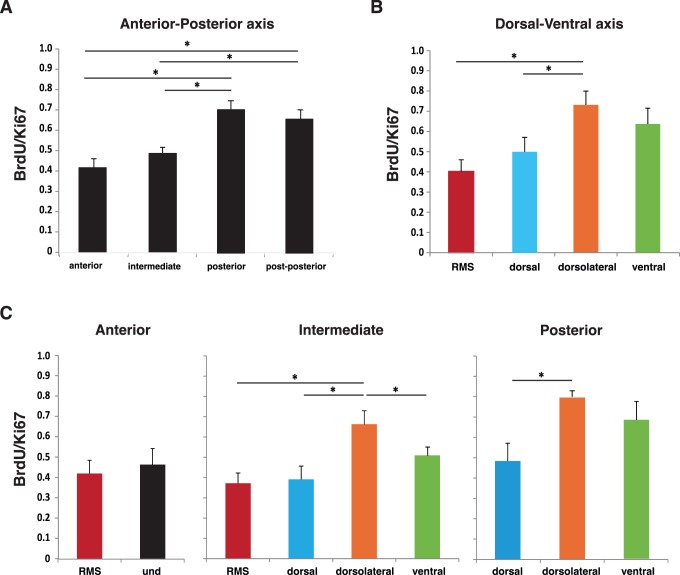
The BrdU/Ki67 ratio differs throughout the subpendymal zone.The SEZ total BrdU/Ki67 ratio is represented for the anterior-posterior (A) and dorsal-ventral axes (B). For the different dorsal-ventral regions the BrdU/Ki67 ratios were assessed at the anterior, intermediate and posterior levels (C). The threshold value for statistical significance was set at 0.05 (* p<0.05).